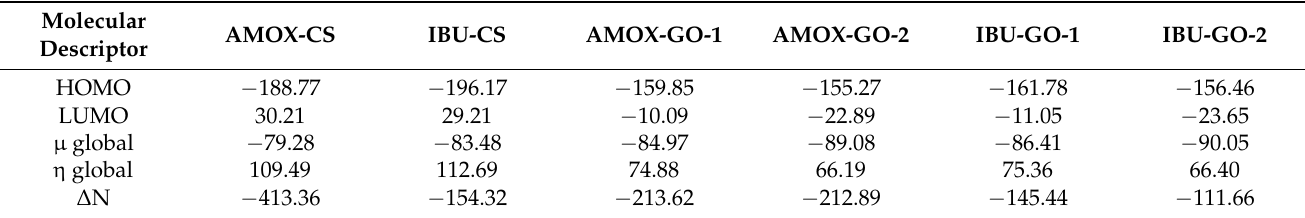
Table 2. Conceptual DFT molecular descriptors * calculated from frontier orbitals, for the complex drugs-absorbent at ω